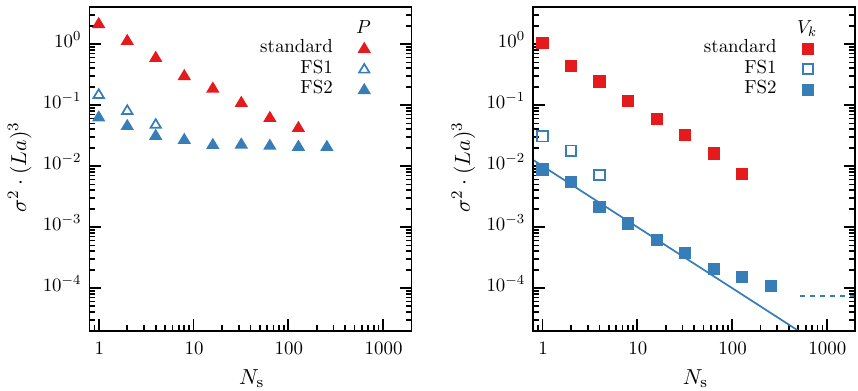
Fig. 5 Variances of the two frequency-splitting estimators FS1 and FS2 (see the main text for explanations) for the pseudoscalar density (left) and the vector current (right) for the ensemble F7 and for the target mass am q = 0 . 00207 corresponding to the sea quark mass. On the horizontal axis, N s is the number of times the frequency-splitting estimator is evaluated and averaged over for each gauge configuration. For comparison the variances of the standard random-noise estimators